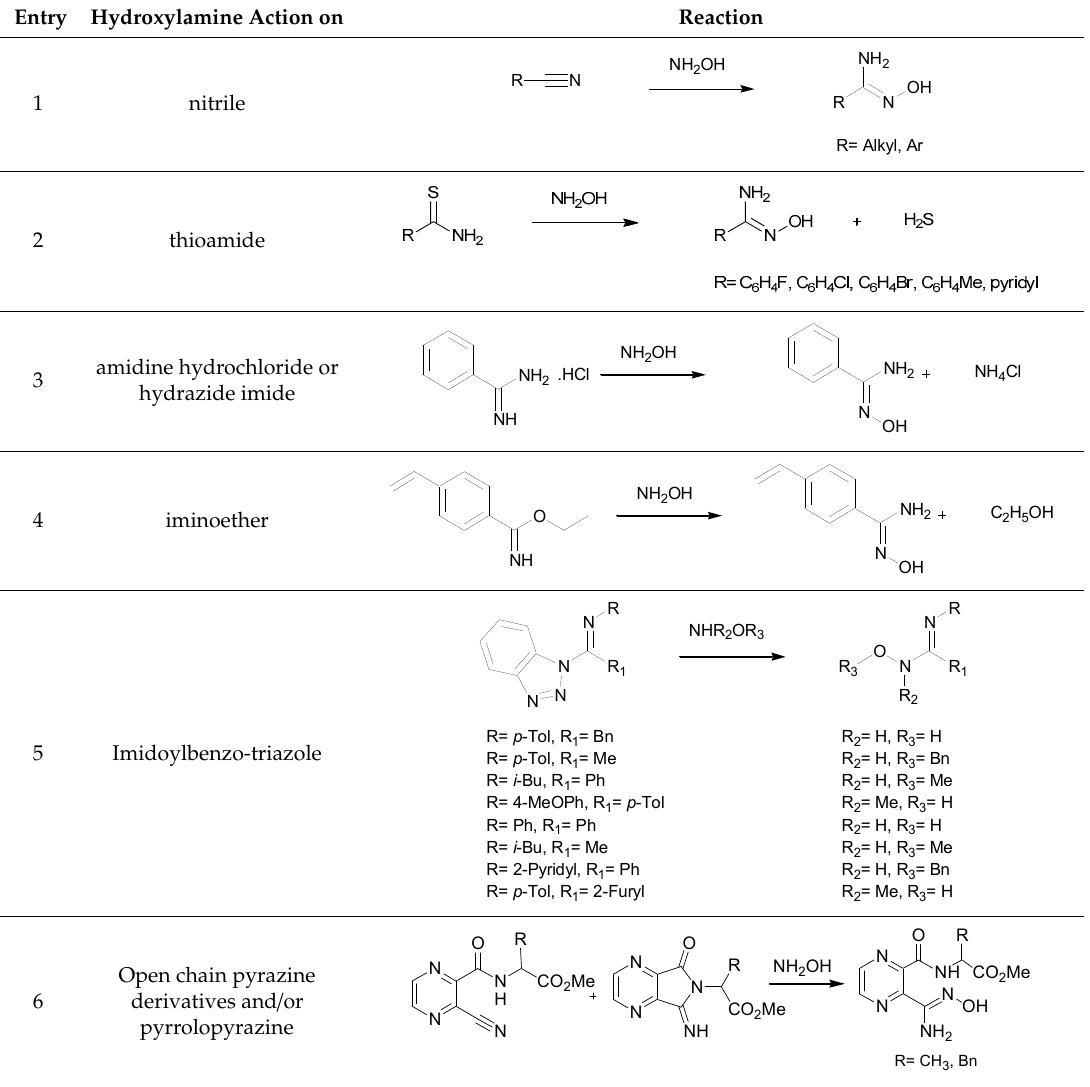
Table 2. Amidoxime syntheses using hydroxylamine.